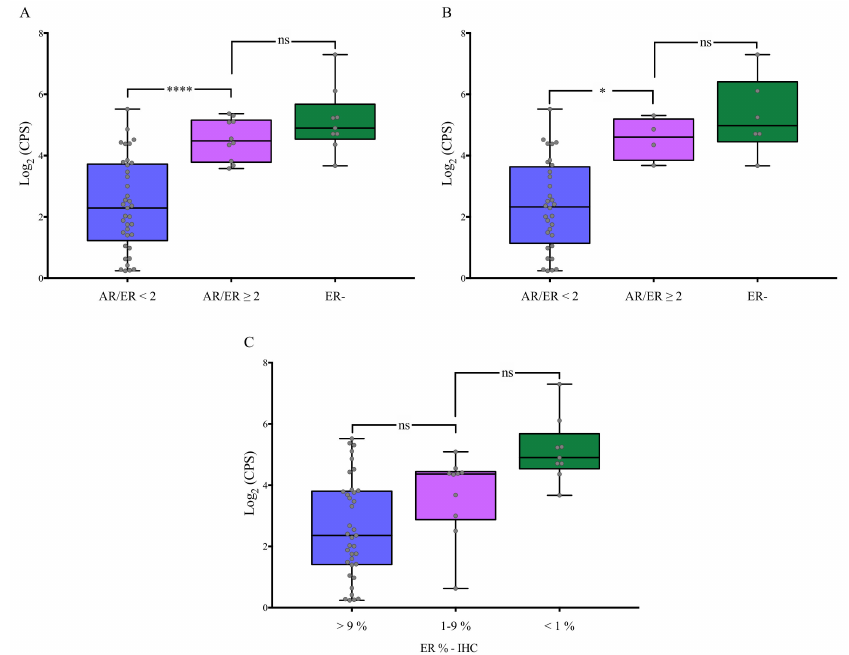
Figure 1. Gene expression cell proliferation signature (CPS) of BC cases grouped by AR / ER ratio, defined by IHC and qPCR methods. Significantly higher levels of CPS were observed in BC cases with ratio AR / ER greater than 2, in both, ER + cases independently of HER2 status ( A ) and also in ER +/ HER2- cases ( B ). However, di ff erences were not identified when tumors were divided by ER% positivity levels ( C ). ER-: estrogen receptor negative < 1%. IHC: immunohistochemistry. Tukey‘s multiple comparison test - **** P < 0.001; * P < 0.05; ns: Not